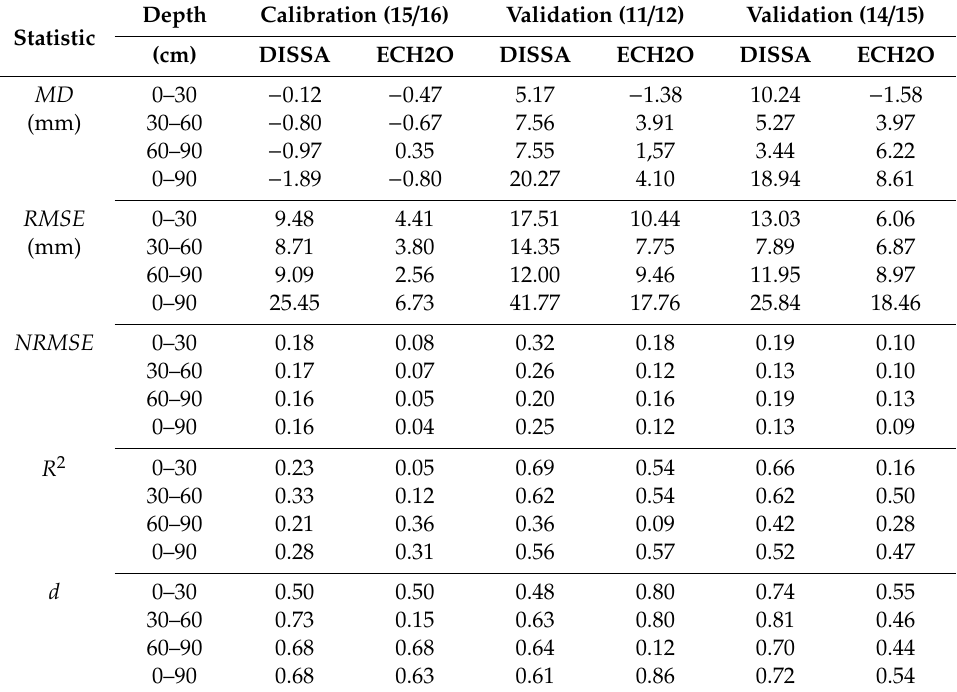
Table 5. Statistical comparisons between observed and simulated soil water depth for barley